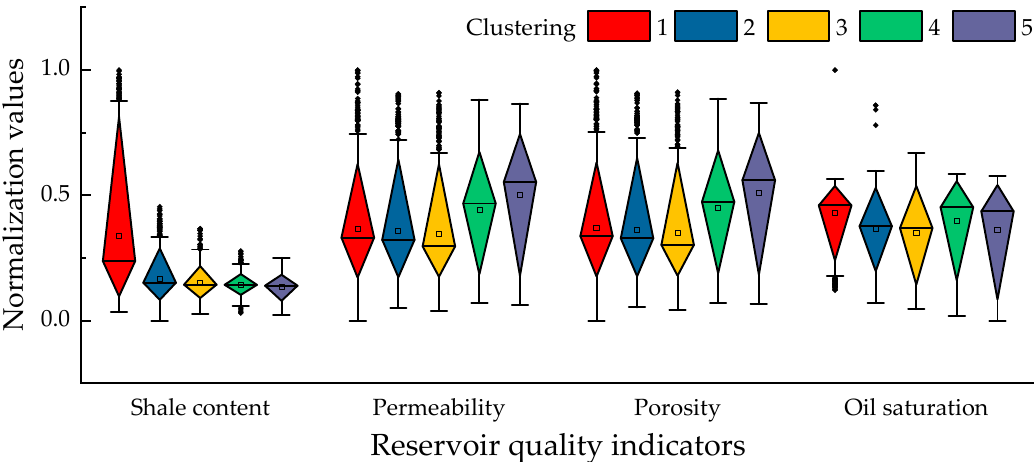
Figure 5. Boxplot of the reservoir quality evaluation index for well A.